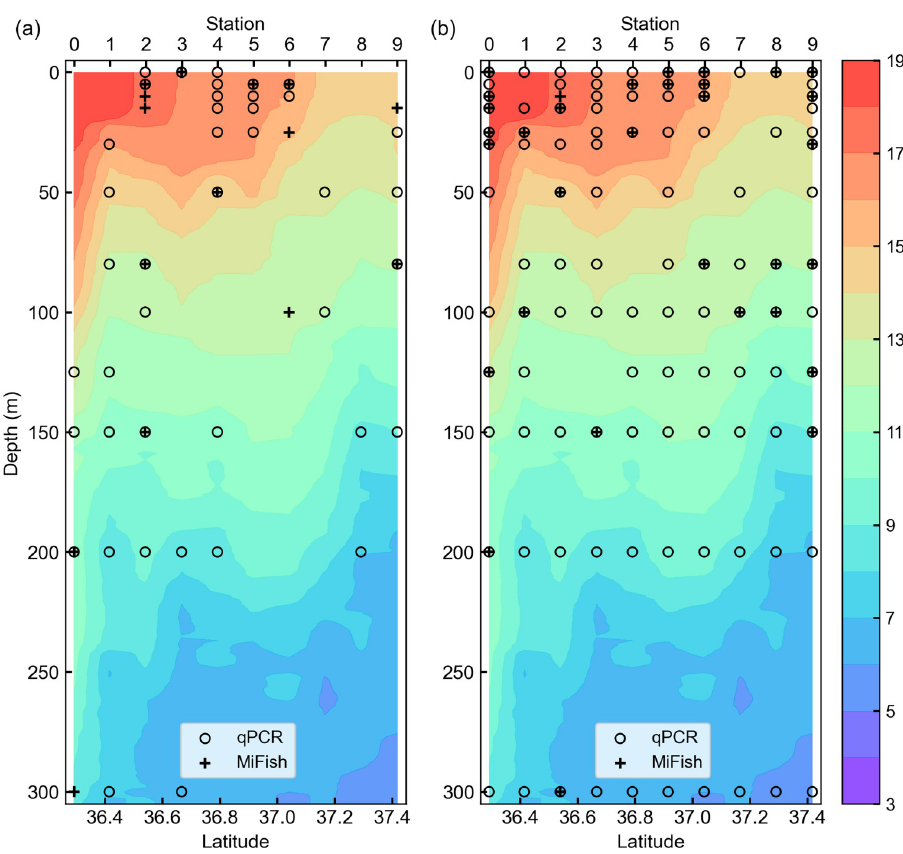
Fig 6. Comparison of spatial distribution pattern detected by qPCR and MiFish methods in the C-line vertical section. (a) Spatial distribution of chub/blue mackerel ( Scomber japonicus and Sc . australasicus ). (b) Spatial distribution of sardine ( Sardinops melanostictus ). Plus marks represent the presence detection samples found by the MiFish method and open circles represent the presence detection samples found by the qPCR method. Background colors represent water temperature